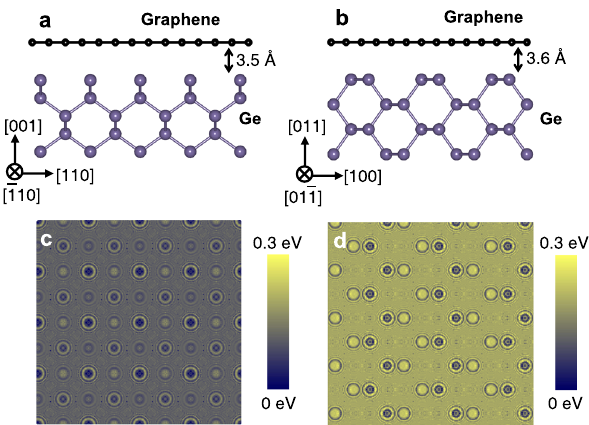
Fig. 1 DFT calculations of surface potential fl uctuations of Ge (001) and Ge (011). Sketches of graphene/Ge systems for a Ge (001) and b Ge (011). DFT-calculated electrostatic potential maps at z = 0.7 nm away from the Ge (001) ( c ) and Ge (011) ( d ) surfaces. The contrast of the images shows the potential fl uctuations with the energy from low (gray) to high